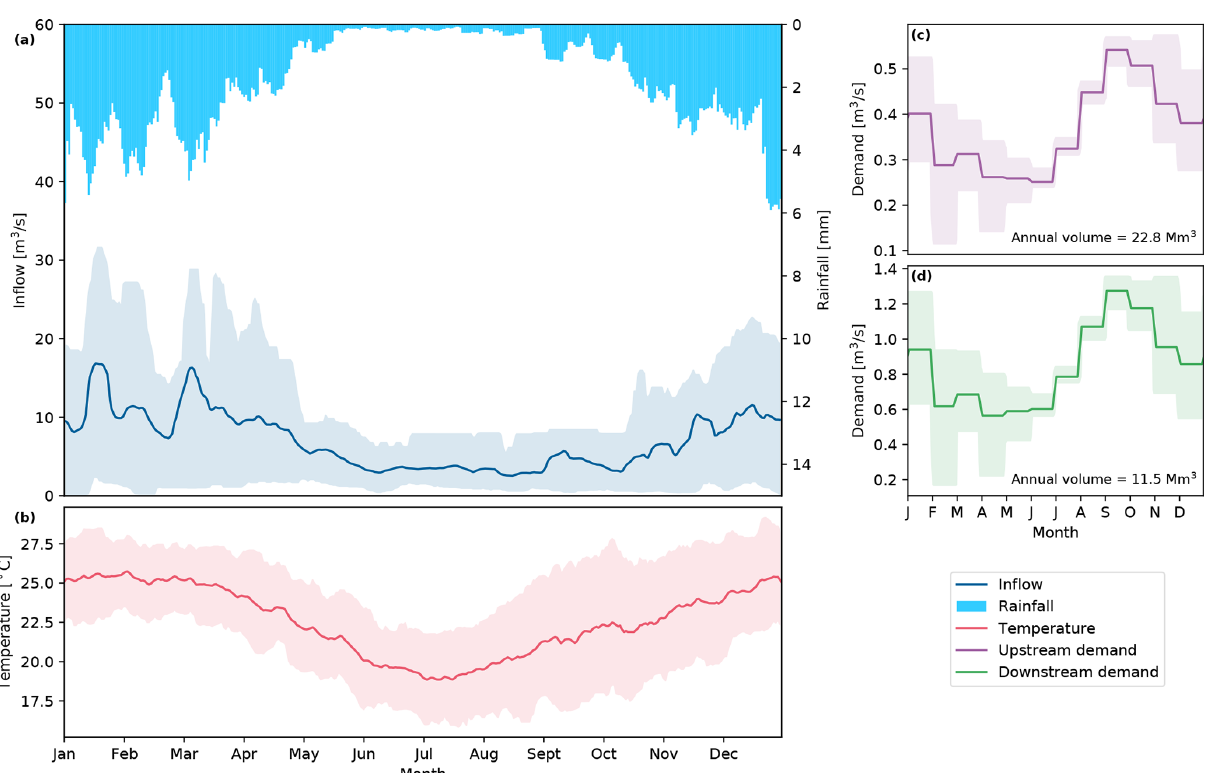
Figure 2. Cyclostationary average of the main hydroclimatic variables computed over a 10d moving window. (a) Precipitation and stream- flow, (b) temperature, (c) downstream irrigation demand, and (d) upstream irrigation demand. The shaded areas represent the 10th–90th interquartile range for each